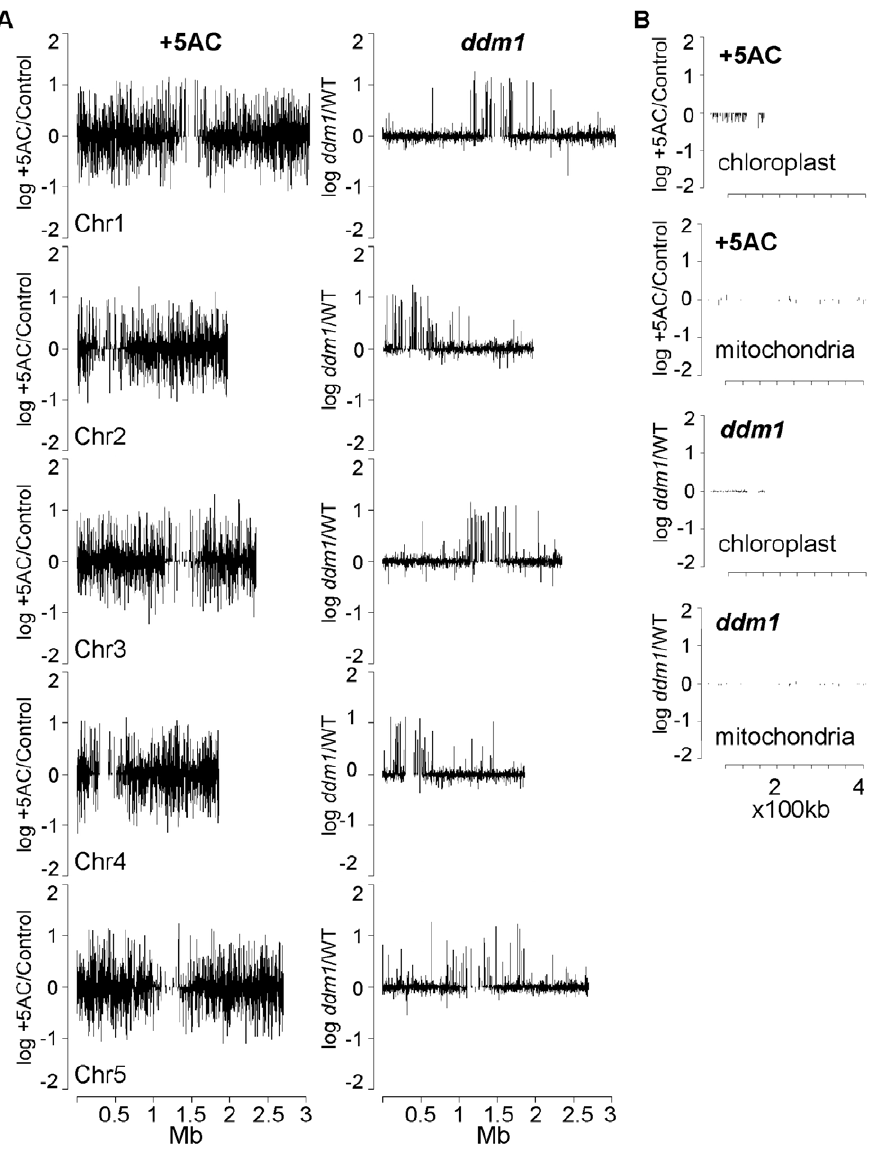
Figure 2. Genes misregulated in ddm1 are not evenly distributed in the Arabidopsis genome. A. log 10 fold-difference values (5-AC/Ws) and ( ddm1 /Ws) are plotted by transcription start site for 5 Arabidopsis chromosomes. B. log 10 fold-difference values for 5-AC treated and ddm1 seedlings for chloroplast and mitochondrial genes.